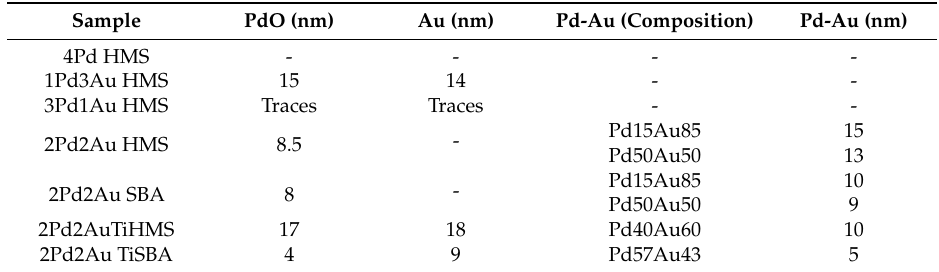
Table 4. XRD derived Crystallite size and phase composition of various Pd-Au catalysts.